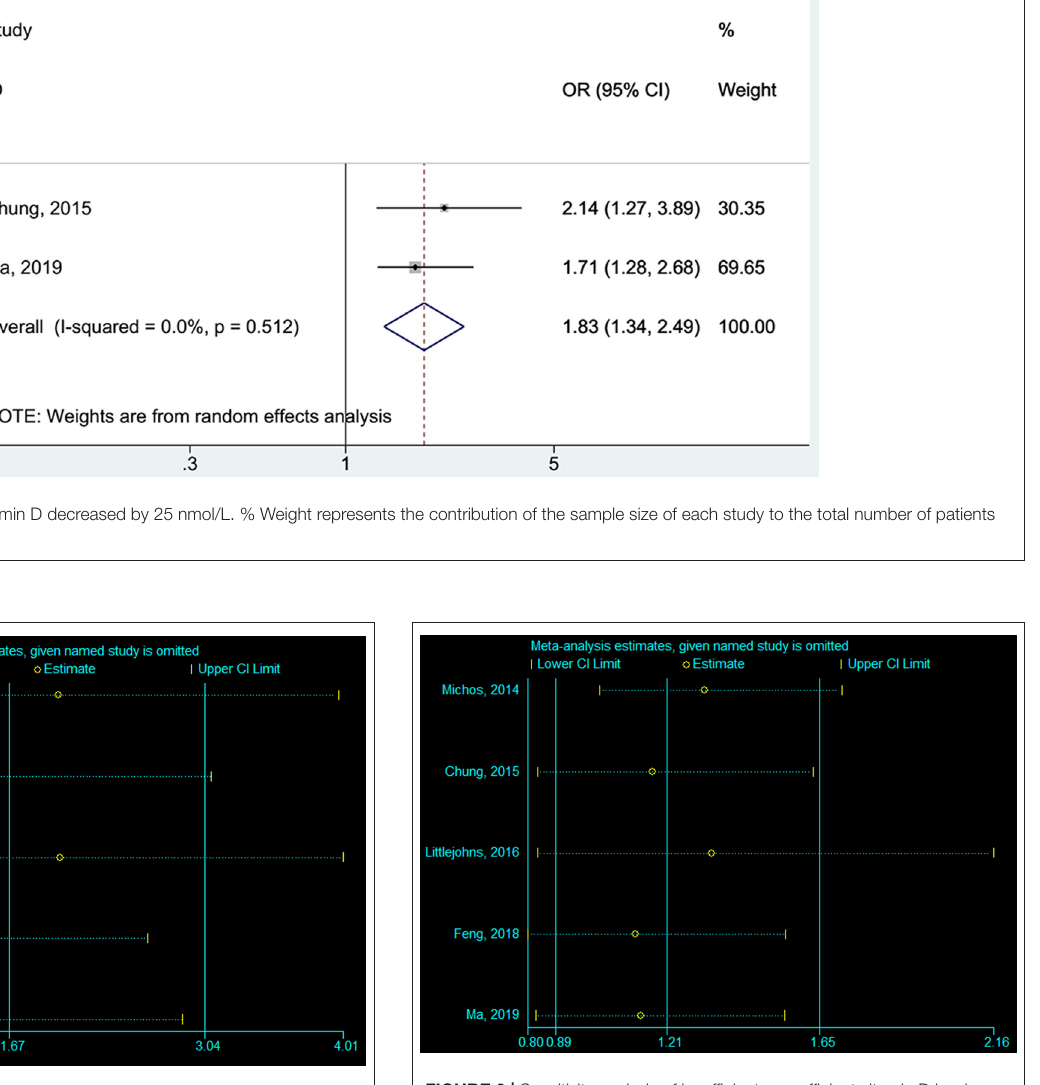
FIGURE 5 | Sensitivity analysis of deficient vs. sufficient vitamin D level.